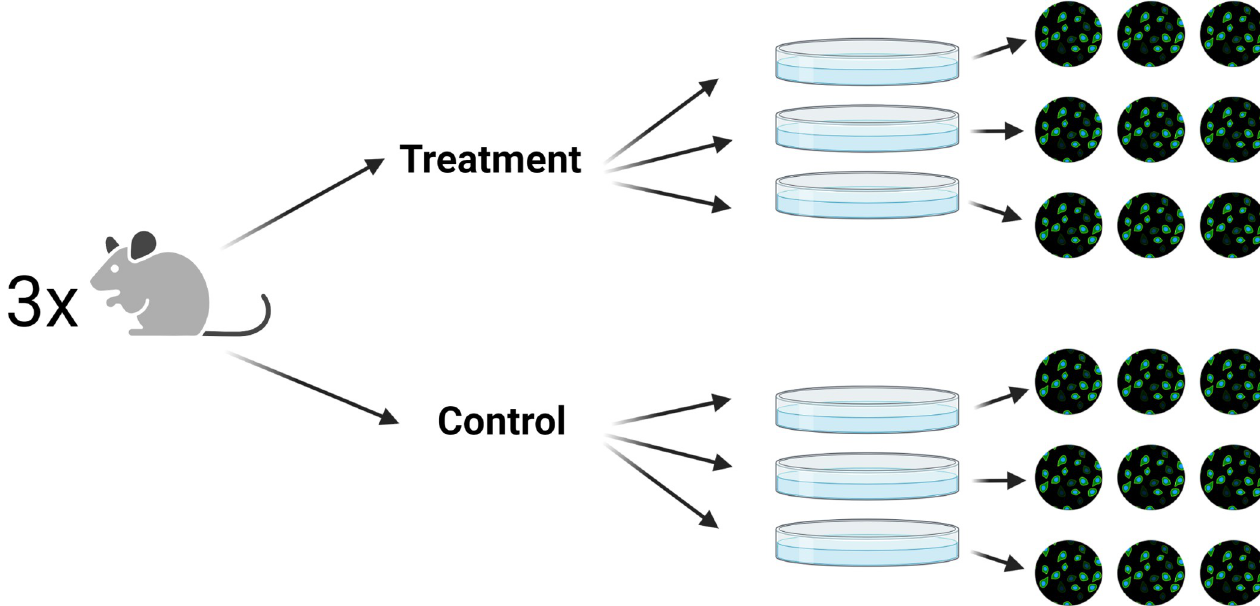
Fig 1. Hierarchical experiments are common in biomedical research. An example of a hierarchical experiment is an imaging experiment, where cells are isolated from donors, which are then treated in separate wells, which are then imaged under a microscope. These experimental designs are common in many fields of research, but especially so in molecular biology, imaging, and neuroscience. Figure was created using